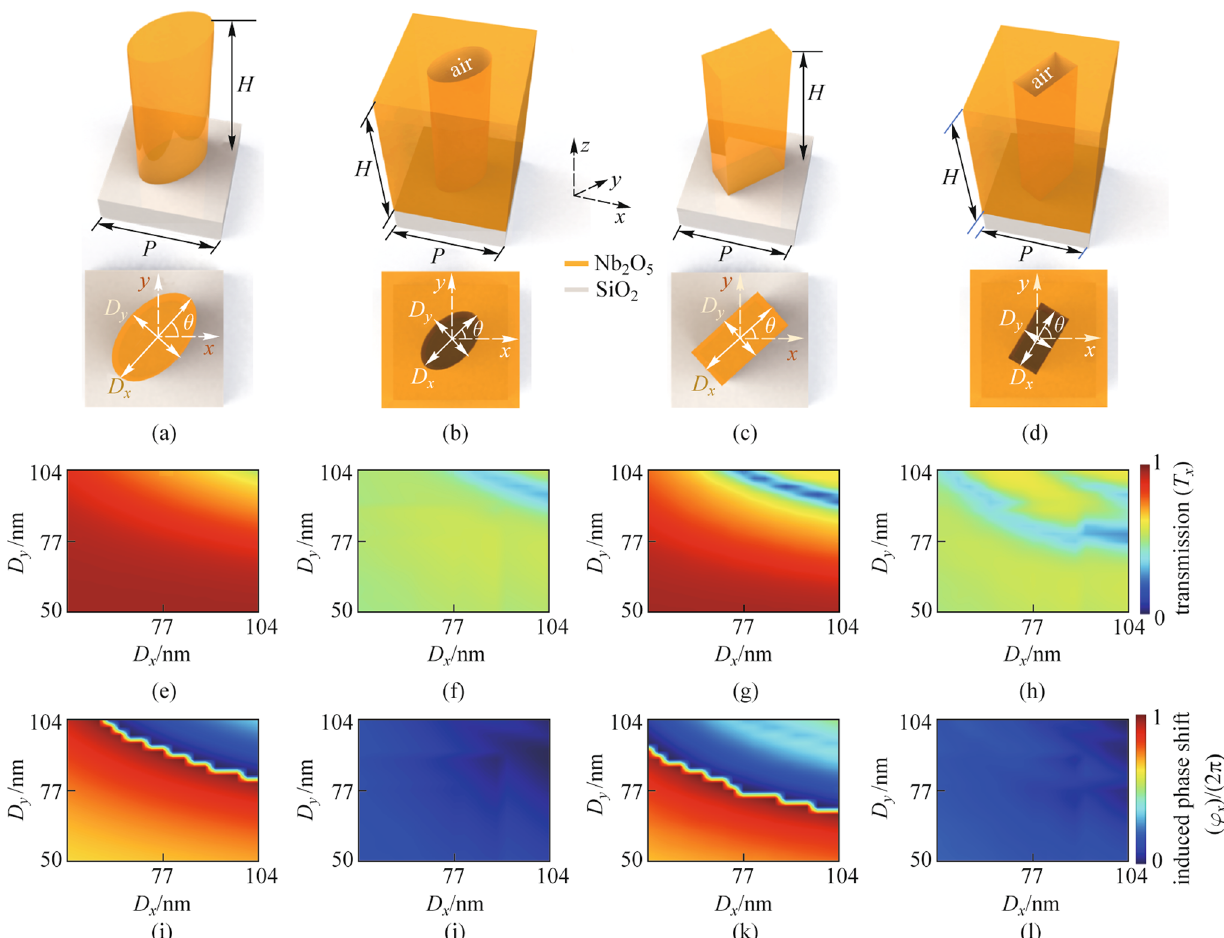
Fig. 2 Schematics of the dielectric or air-hole nanopillars and the corresponding transmittances and induced phase-shift under the normal incidence of the x -LP plane wave at the wavelength of 350 nm. a – d are the 3D structure and top-view of four types of nanopillars. e – h are the transmittances T x and i – l are the phase-shift 𝝋 x of the nanopillars with different values of D x and D y . The dielectric or air-hole nanopillars have an elliptical/rectangular cross-section with a long axis and short axis of D x and D y ; 𝜃 is the rotation angle of the long axis relative to the x-